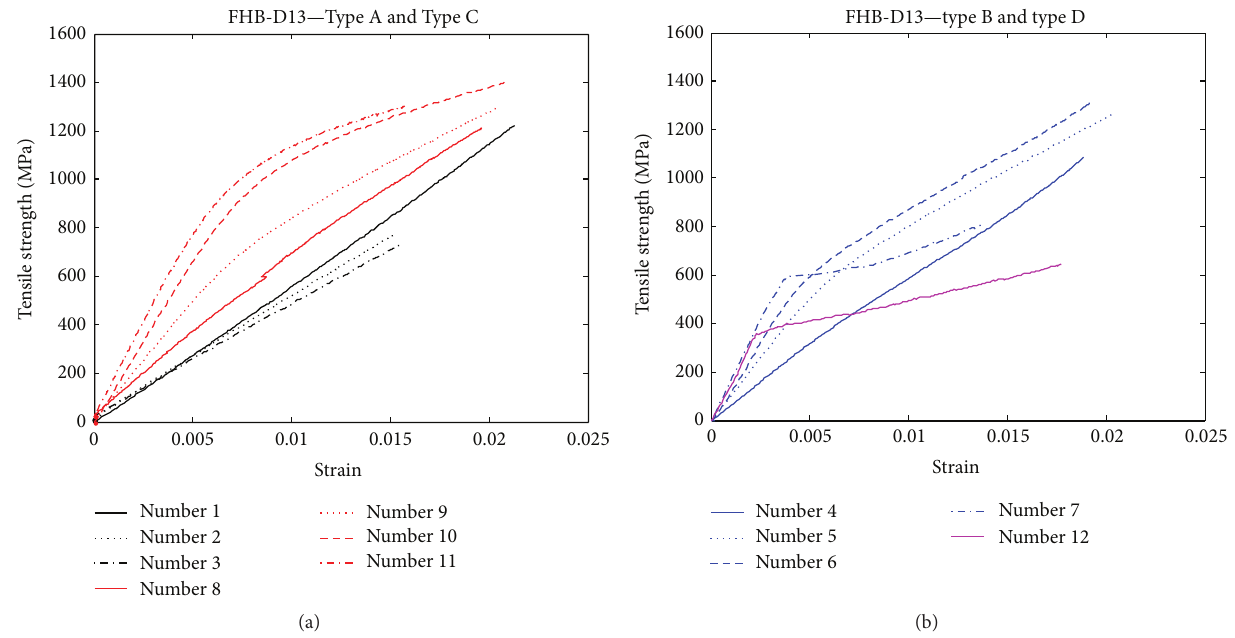
Figure 12: Stress-strain curves of D13 FRP Hybrid Bar: (a) Types A and B; (b) Type B and Type D.